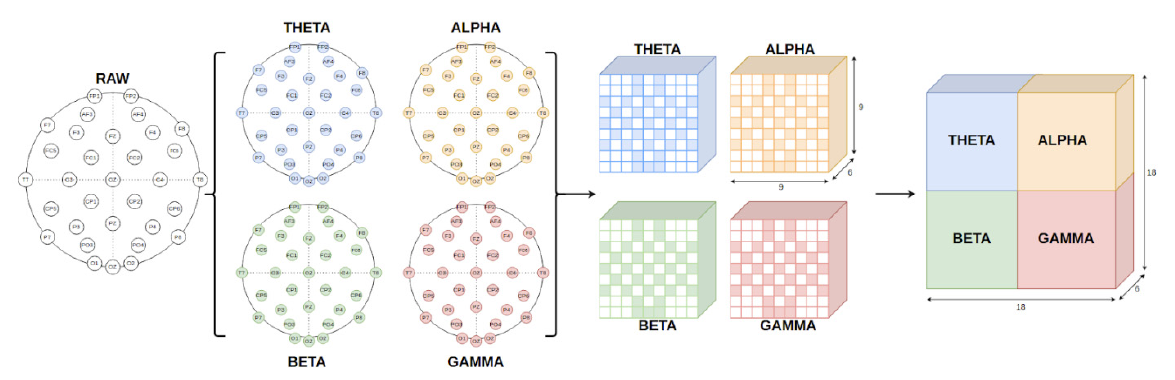
Figure 2. The framework of the feature extraction procedure.